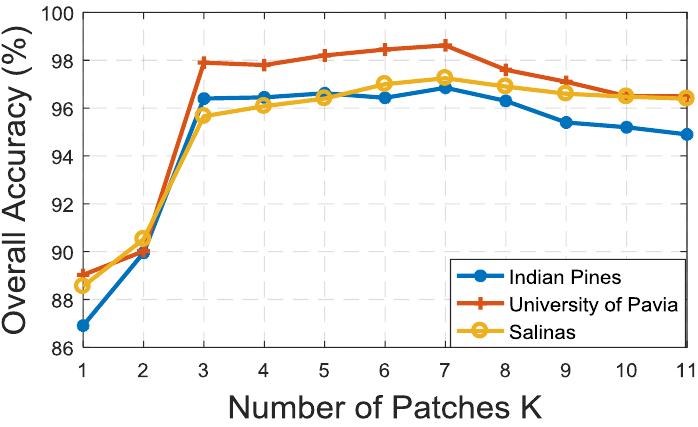
Figure 8. The effect of number of patches of MLSR on three datasets.